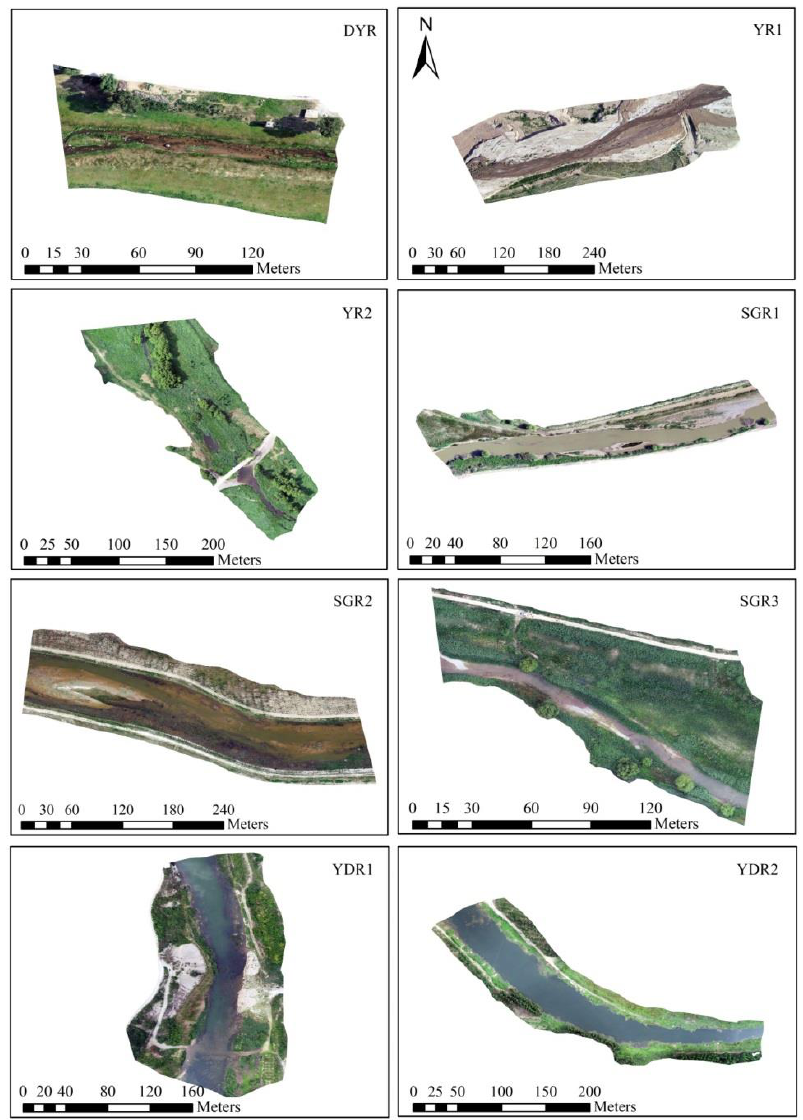
Figure 2. Unmanned aerial vehicle (UAV) images of the eight selected reaches.